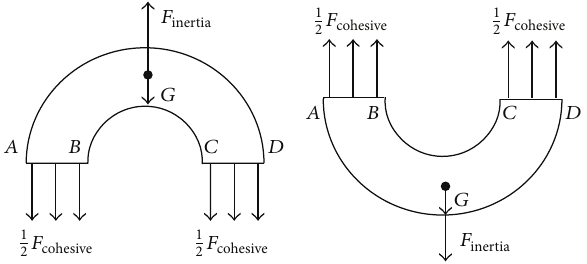
Figure 1: Free-body diagram of ice